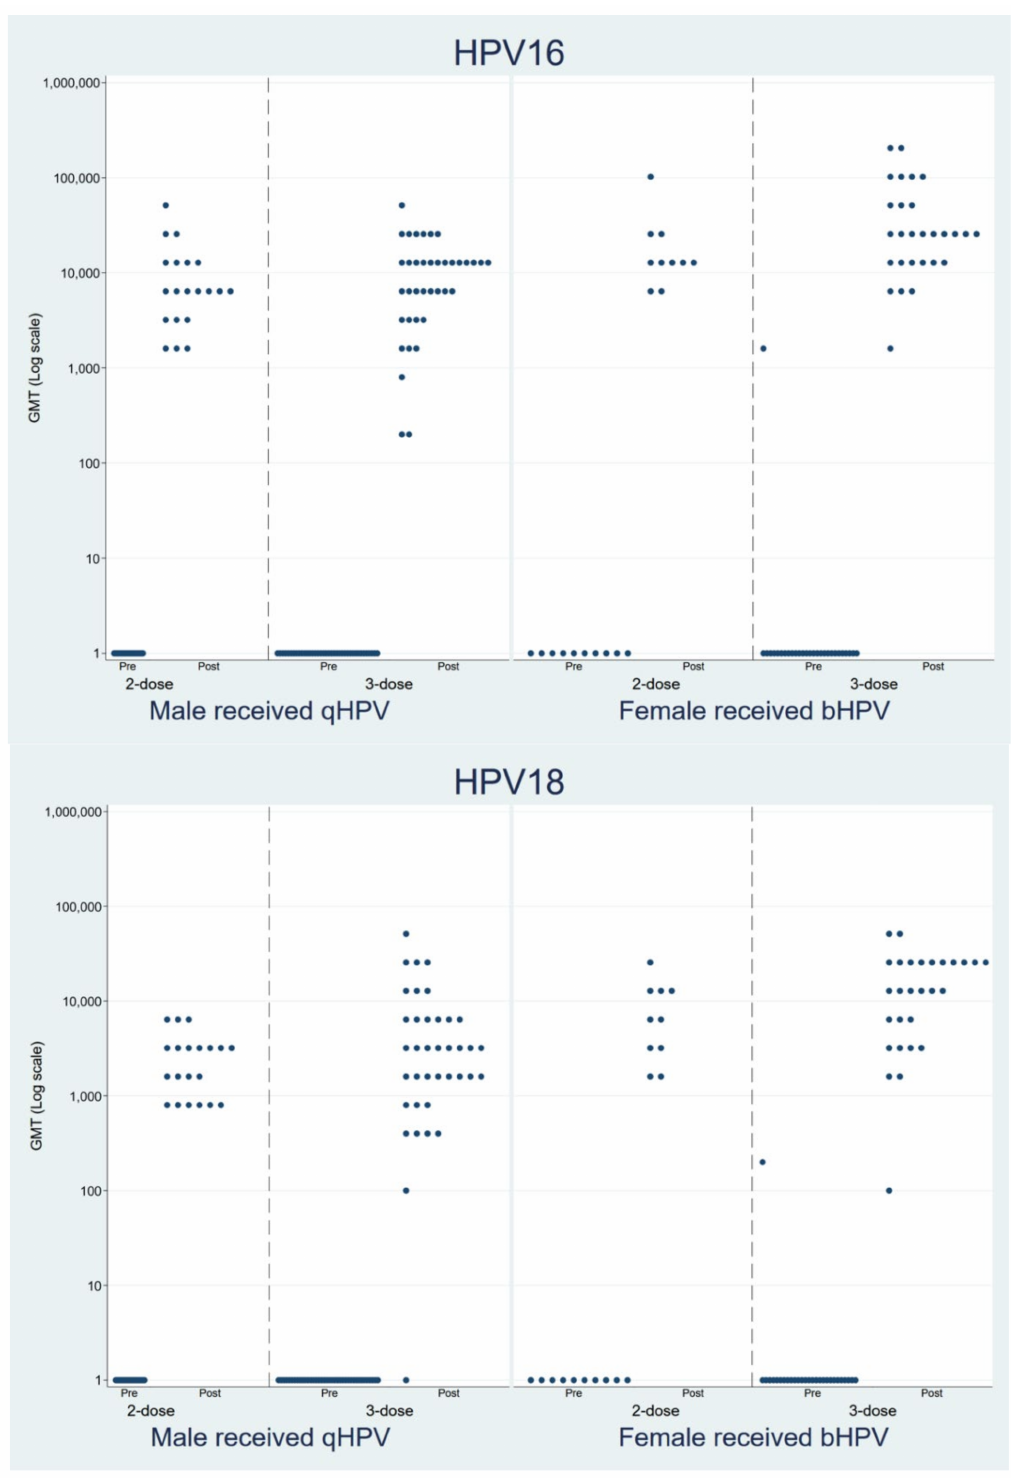
Figure 1. The geometric mean titers of human papillomavirus 16 and 18 among the 2- and 3-dose groups, Cervarix ® and Gardasil ® at pre-vaccination, and at 1 to 3 months after the last